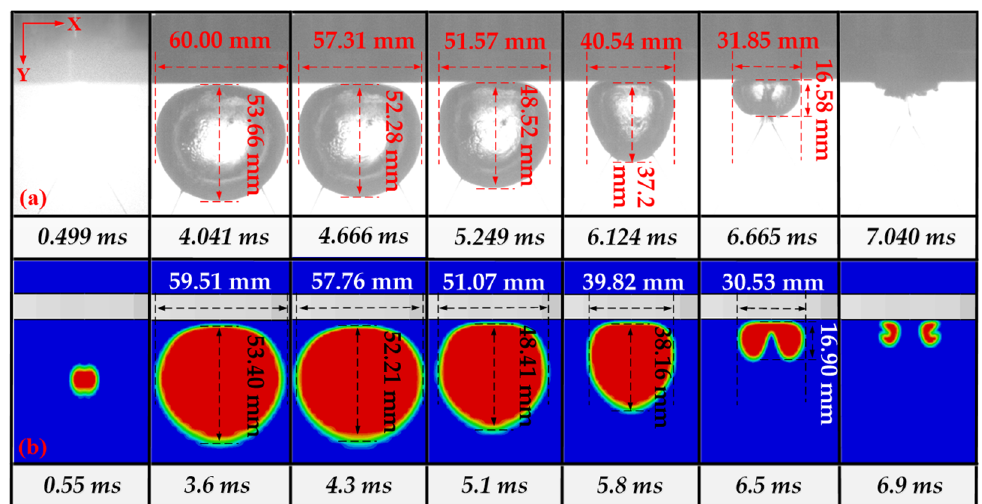
Figure 18. A pulsation chart of the first cycle of the bubble when γ = 0.83 and ζ = 0: ( a ) Electric spark bubbles generated by 400 V high-voltage electric discharge; ( b ) high-pressure cavitation bubbles simulated by ABAQUS/Explicit.